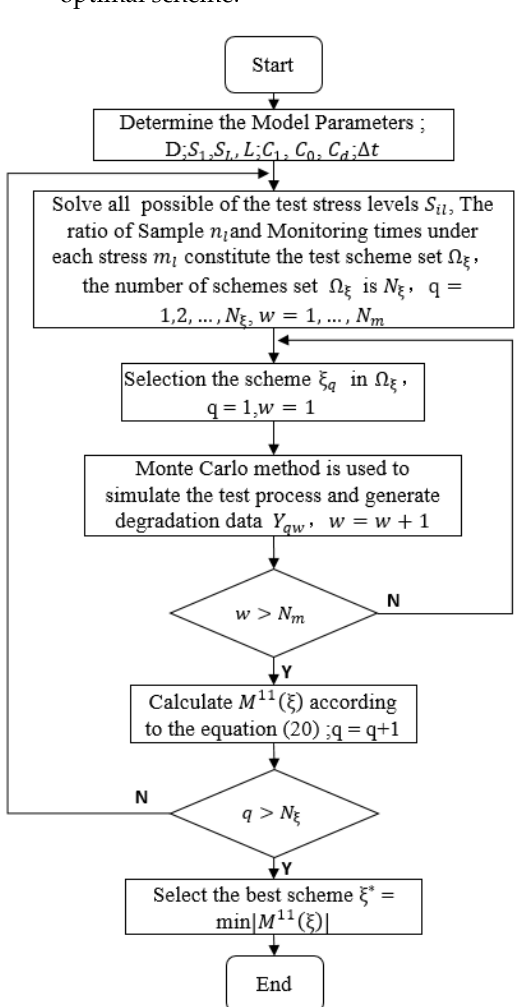
Figure 5. Optimization process of accelerated degradation test scheme for the motorized